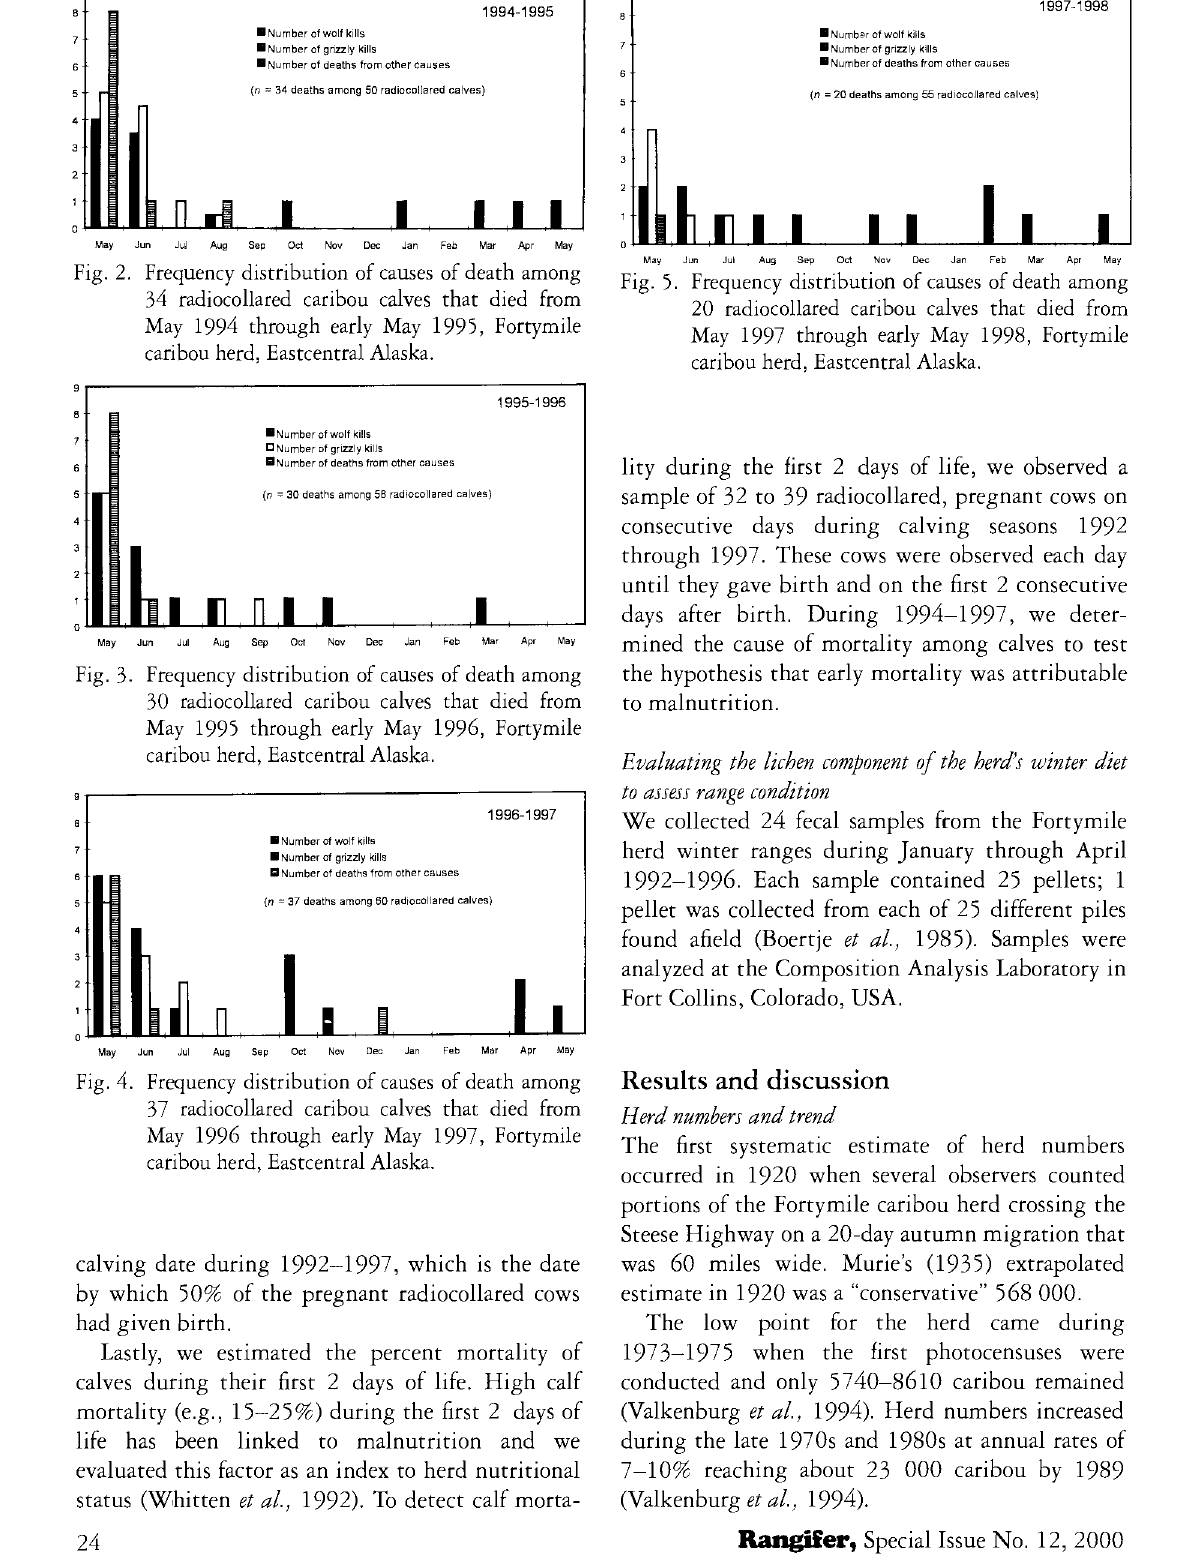
Fig. 2. Frequency distribution of causes of death among 34 radiocollared caribou calves that died from May 1994 through early May 1995, Fortymile caribou herd, Eastcentral Alaska.